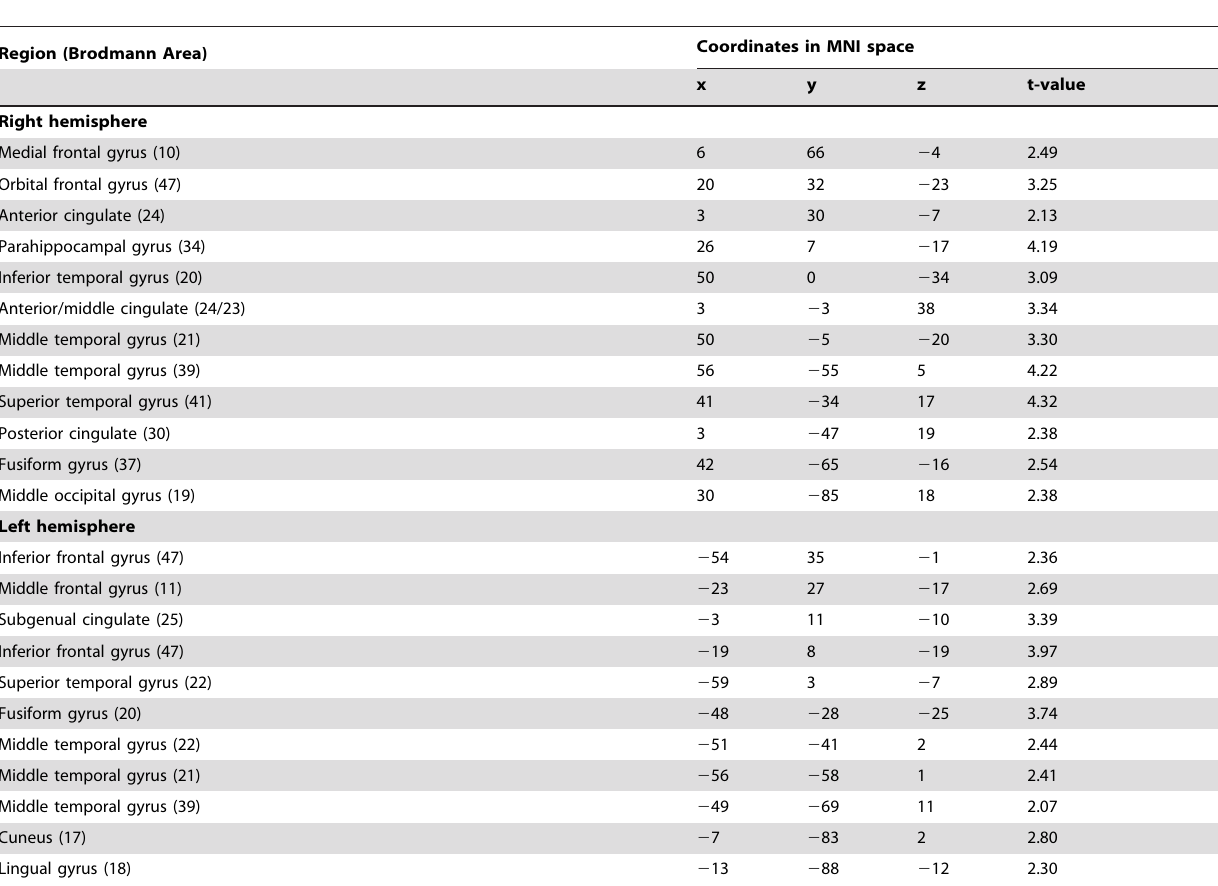
Table 3. Areas of cortical thinning in PNS patients compared to non-PNS